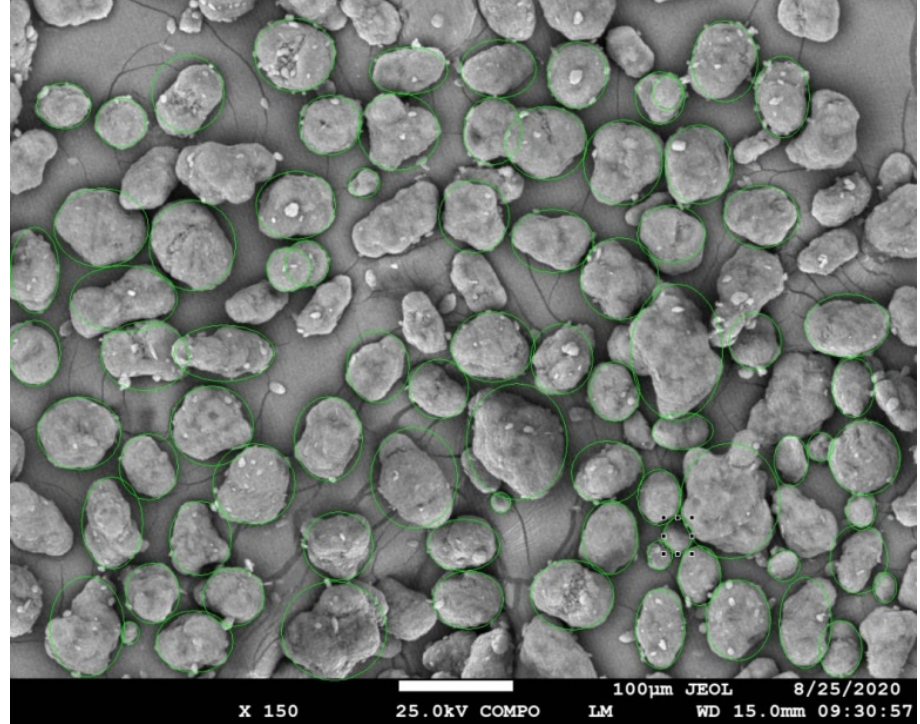
Figure 3. Example SEM image of analyzed material. Particle size image analysis, where all shapes are approximated as round circle-equivalent or oval.